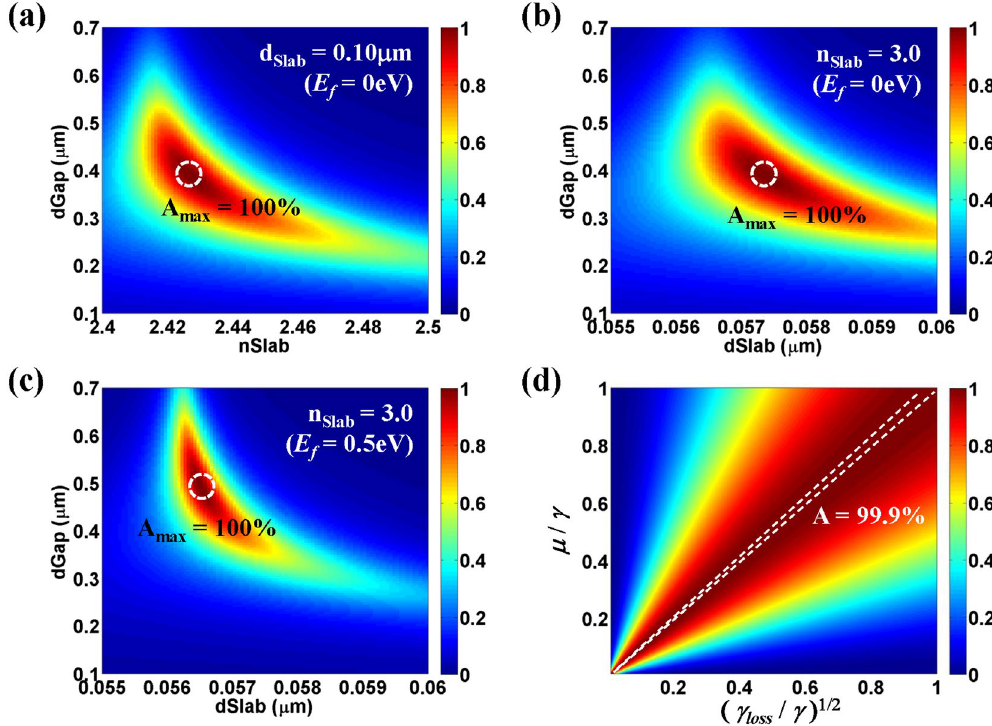
Figure 4. Various optimizations of absorption by RCWA at λ = 1.2805 μ m for the proposed absorber ( a ) when d Slab = 0.10 μ m, E f = 0 eV, ( b ) when n Slab = 3.0, E f = 0 eV, and ( c ) when n Slab = 3.0, E f = 0.5 eV, assuming that the remaining HCG parameters are the same as the optimal conditions considered in Fig. 2(f); that is, n H = 3.0, n L = 1.5, Period = 0.9 μ m, FF = 0.43, and d Grat = 0.32507 μ m. ( d ) Absorption spectra by CMT as a function of loss rate and direct coupling strength, assuming that μ = μ 1 = μ 2 and the remaining fitting parameters are the same as the optimal condition in Fig. 2(b). Two dashed lines indicate A =